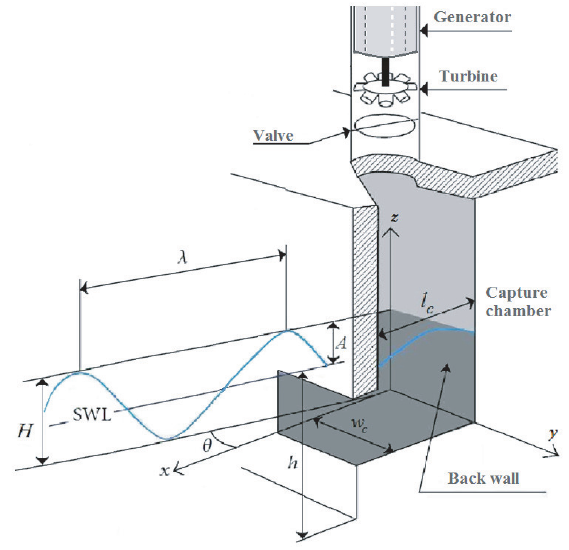
Figure 1. Scheme of an oscillating water column system and the sea